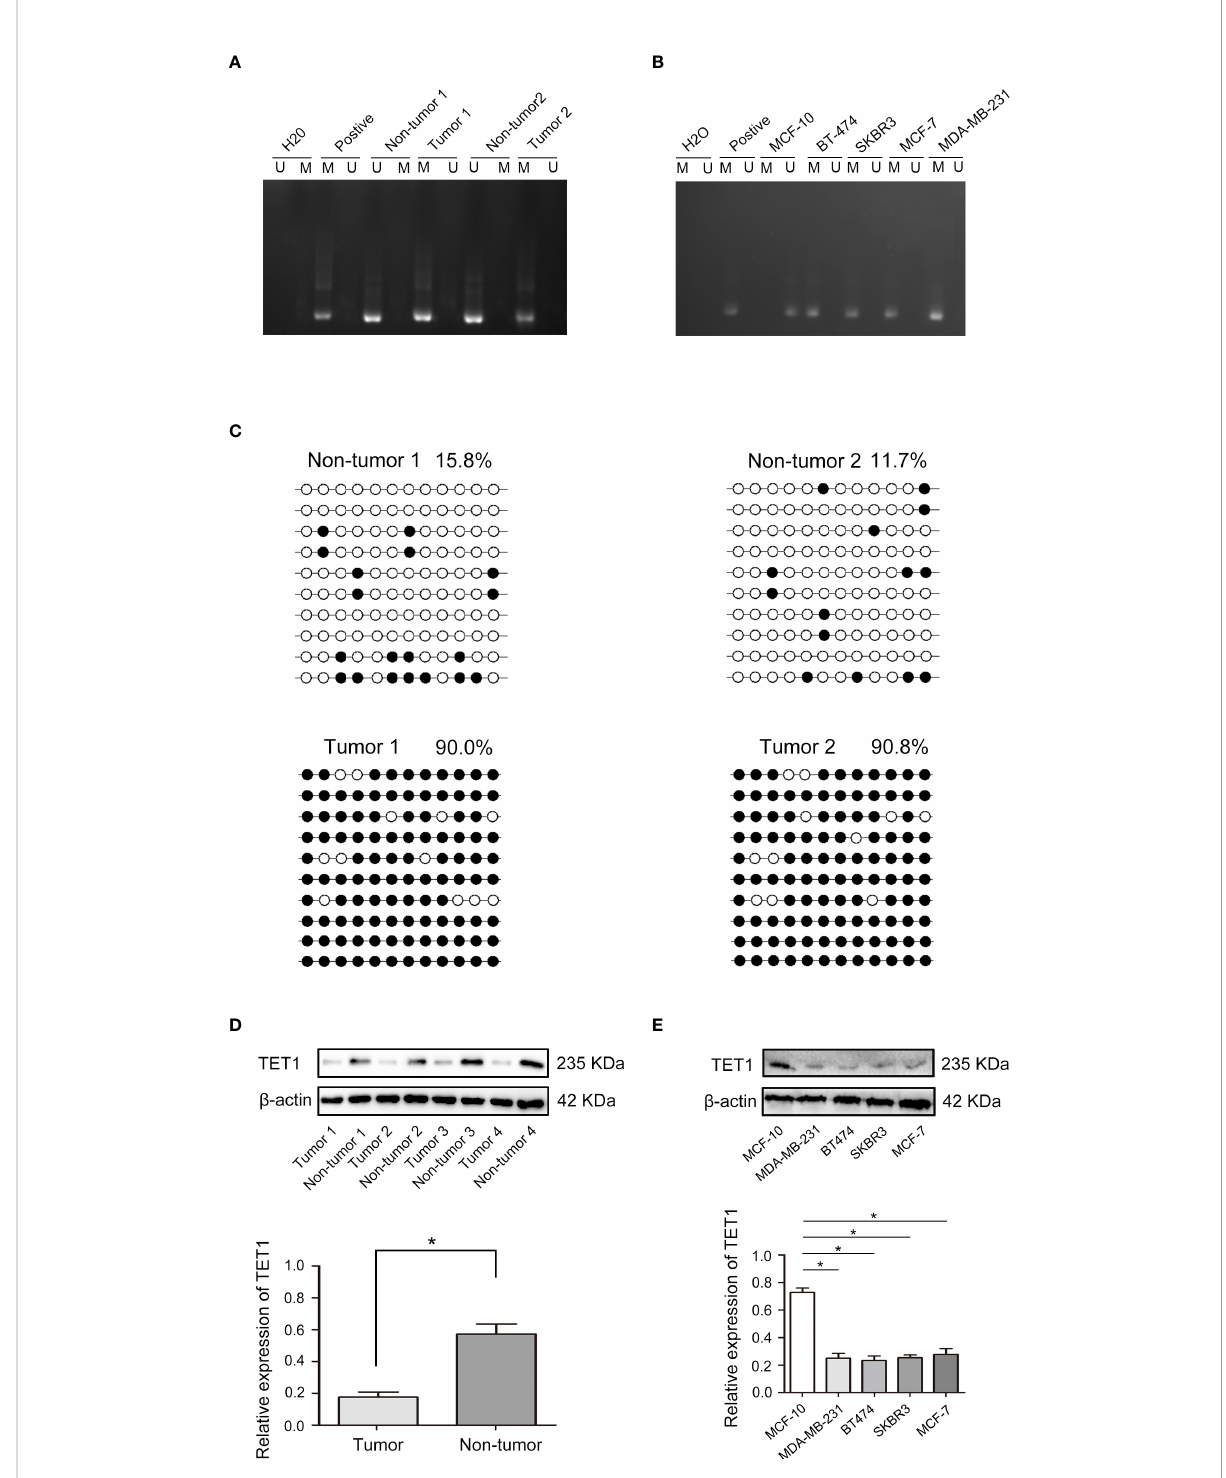
FIGURE 4 Aberrant DNA hypermethylation of ADCY6 and aberrant expression of TET1 in breast cancer. (A) The methylation status of ADCY6 was randomly detected in breast cancer tissues. (B) The methylation status of ADCY6 was detected in breast cancer cell lines. (C) Bisul fi te sequencing analysis was performed on ADCY6 promoter methylation in randomly detected breast cancer tissues. Black dots, methylated; white dots, unmethylated. (D) The protein expression of TET1 in breast cancer samples. *p < 0.05 versus adjacent normal tissues. (E) The protein expression of TET1 in breast cancer cell lines. *p < 0.05 versus MCF-10 cells. Black dots and M, methylated; white dots and U,